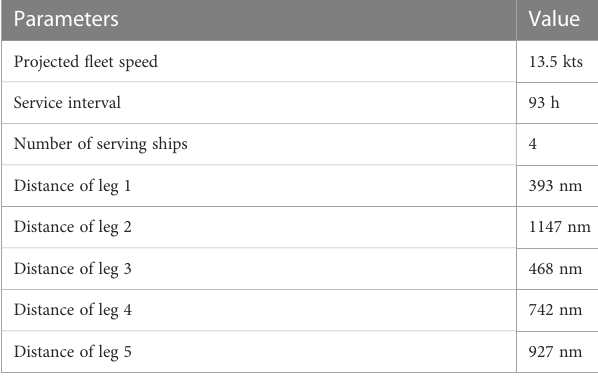
TABLE 1 Shipping route parameters.